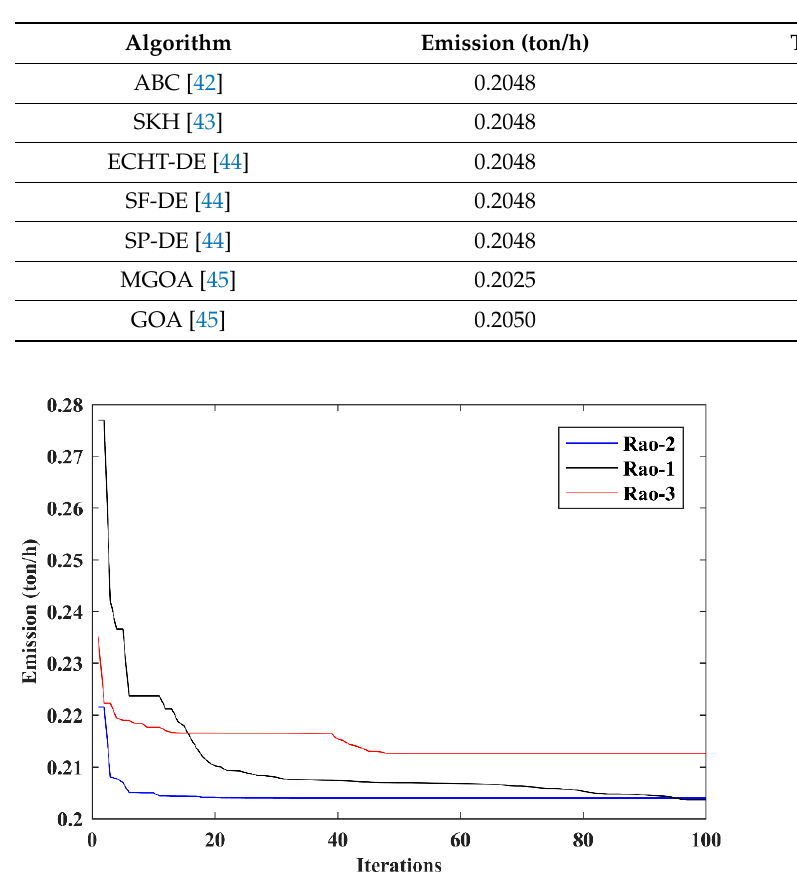
Figure 5. Convergence characteristic for the IEEE 30-bus system, Case 6. Table 9. Case 6: ECM in the IEEE 30-bus system.